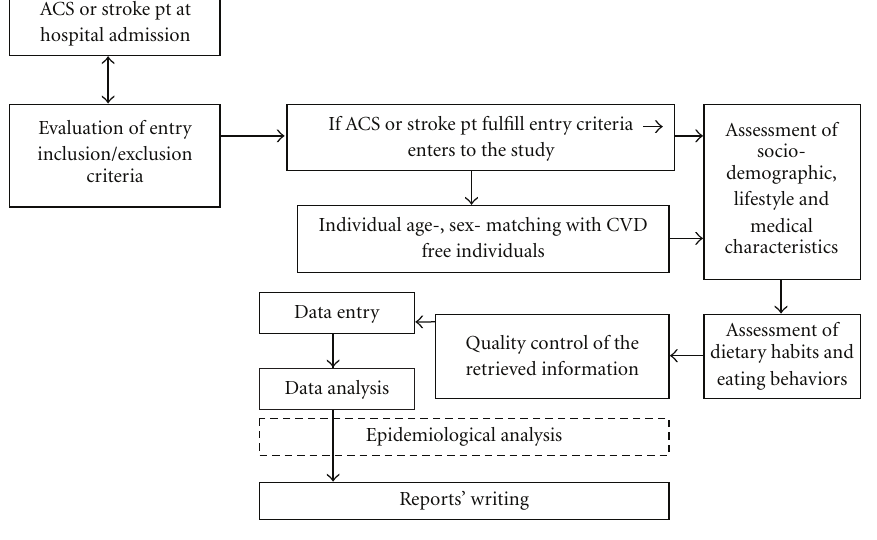
Figure 2: Flowchart of the